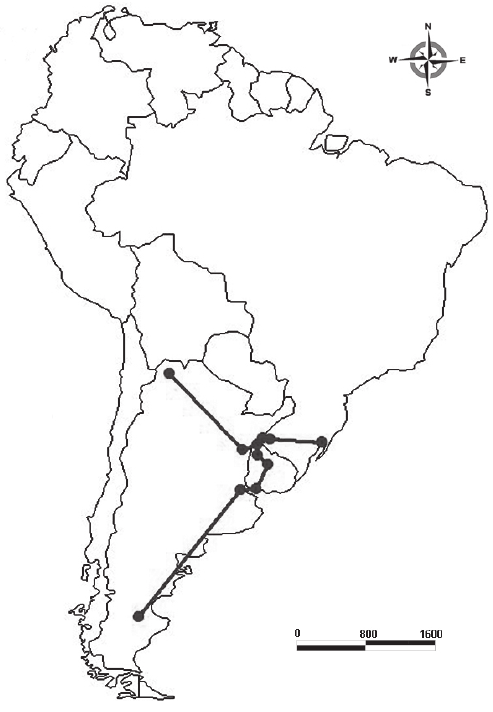
Fig. 14 - Individual track of Mylodon darwini .